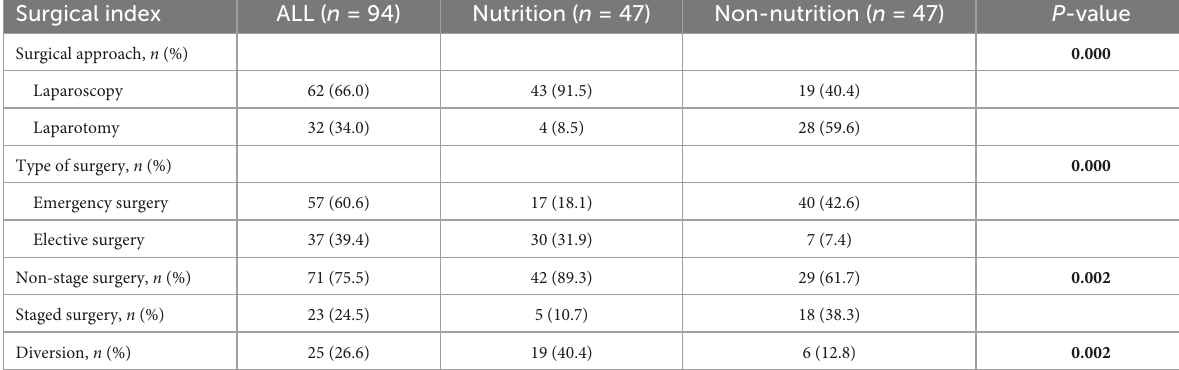
TABLE 4 Operative data.